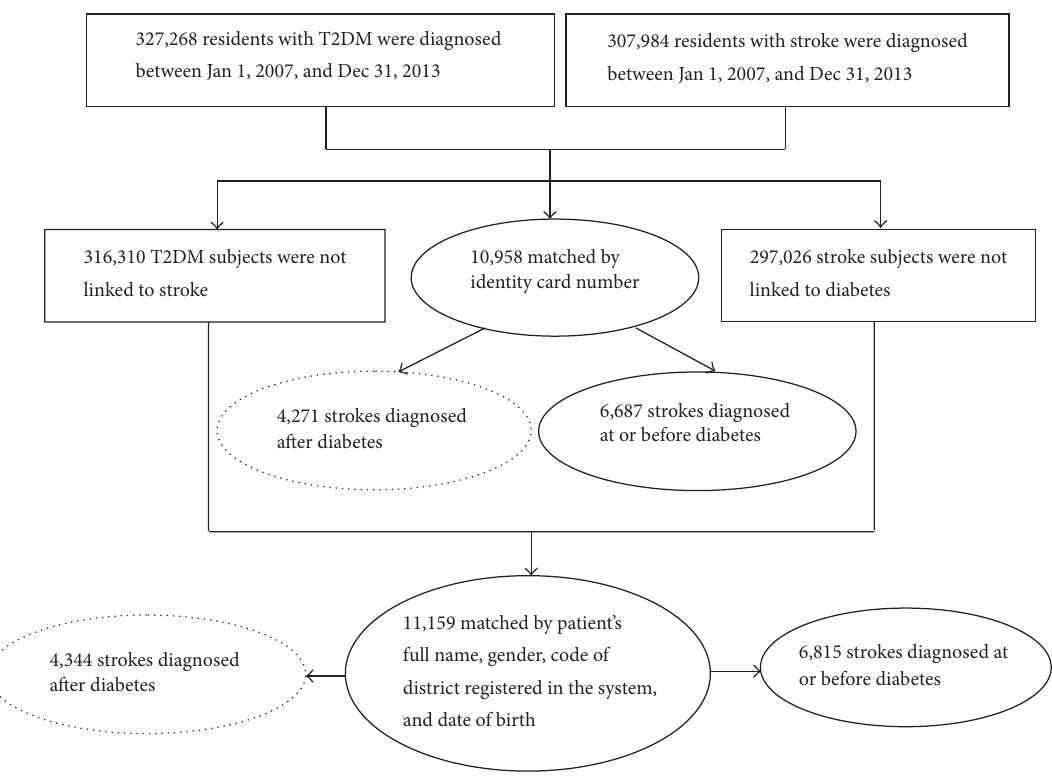
Figure 1: Flowchart of data linkage between Diabetes Surveillance System and Stroke Surveillance System of Zhejiang in